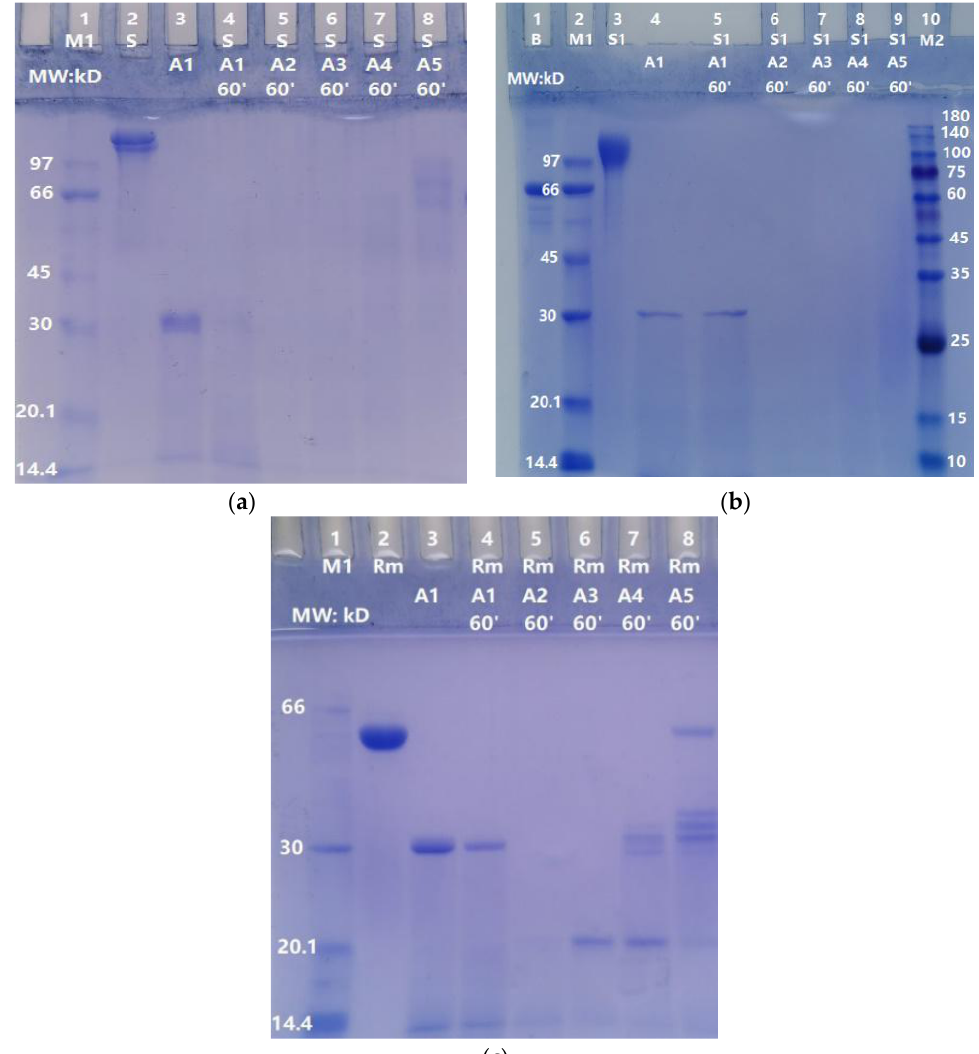
Figure 2. Degradation of S protein, S1 protein, and RBD-mouseFc by ASPNJ of different concentra- tions : ( a ) degradation of S; ( b ) degradation of S1; and ( c ) degradation of RBD-mouseFc (Rm). The concentration of S, S1, and Rm were all 10 μg/lane. A1 -A5 were ASPNJ/lanes of different concentra- tions (A1-A5 were 50 (or 30), 1, 0.2, 0.04, 0.008 μg/lane, respectively). Each of the three proteins was degraded by ASPNJ, with a total volume of 25 μL, at 40 ℃ for 60 min, and the degradation effect was observed by running SDS-PAGE.